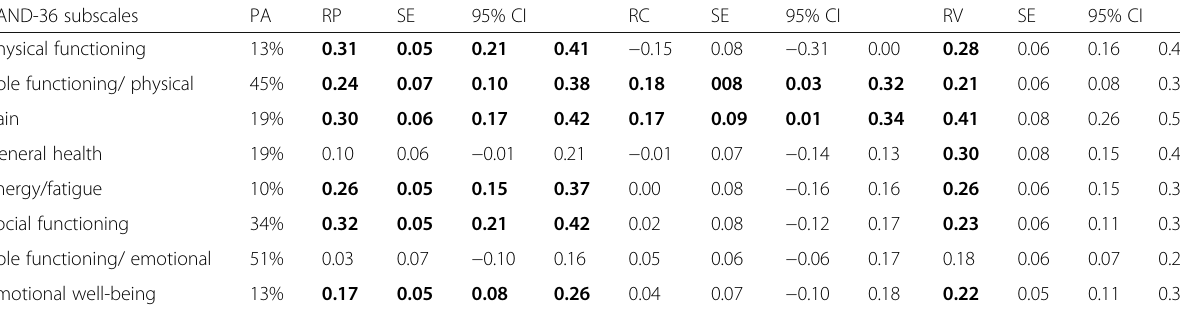
Table 8 Responsiveness analysis using Svensson ’ s method for ordinal paired data for the Cardiac rehabilitation patients RAND-36 subscales PA RP